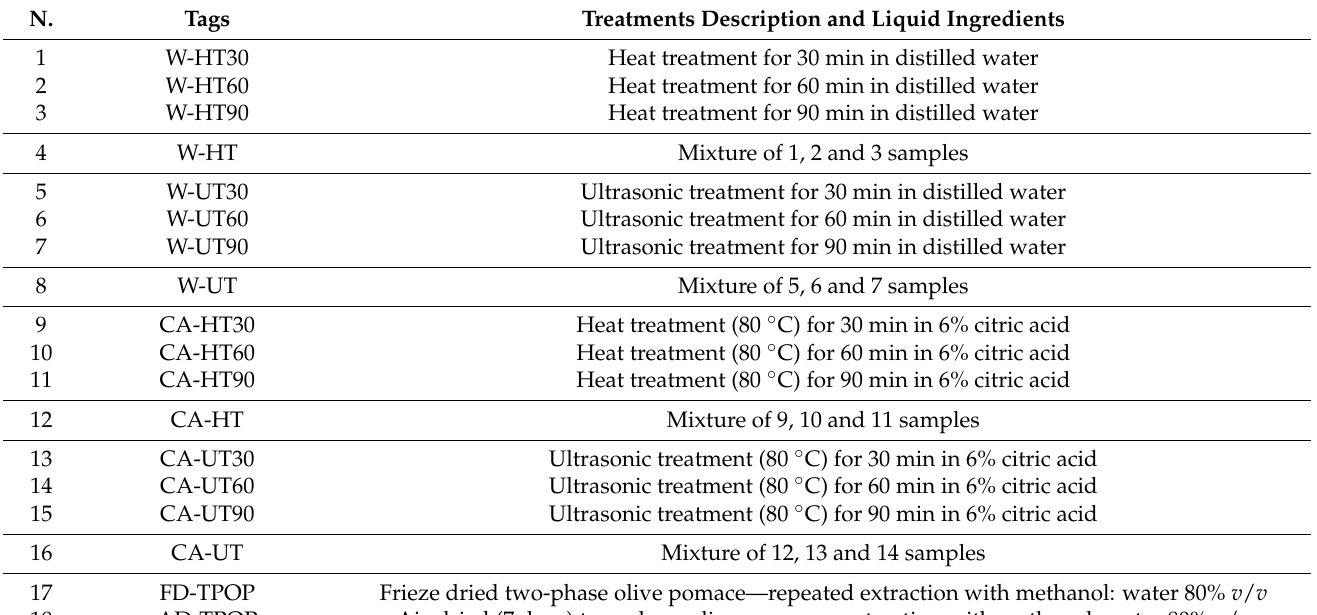
Table 1. List of samples in function of the treatments and liquid ingredients applied.